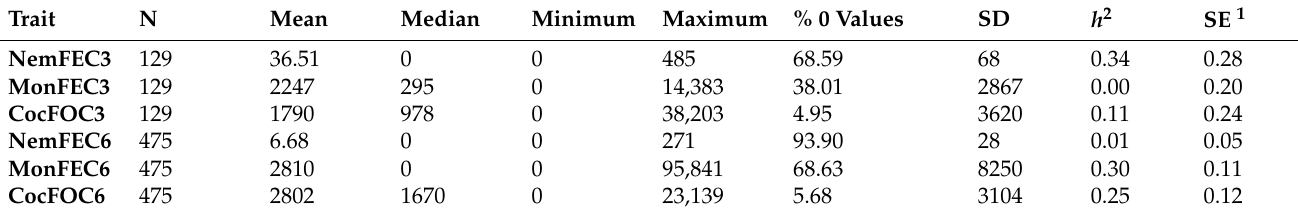
Table 1. Descriptive statistics and genomic heritability estimates ( h 2 ) of fecal